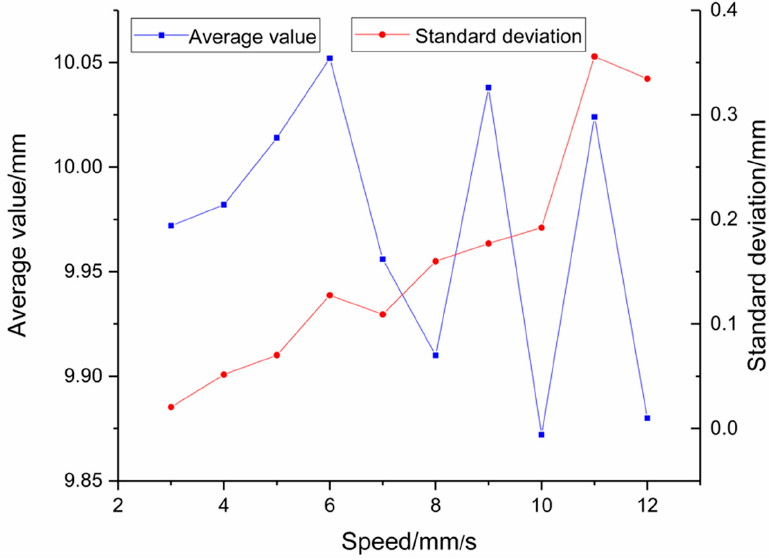
Figure 11. The average value and standard deviation under different feed speeds.